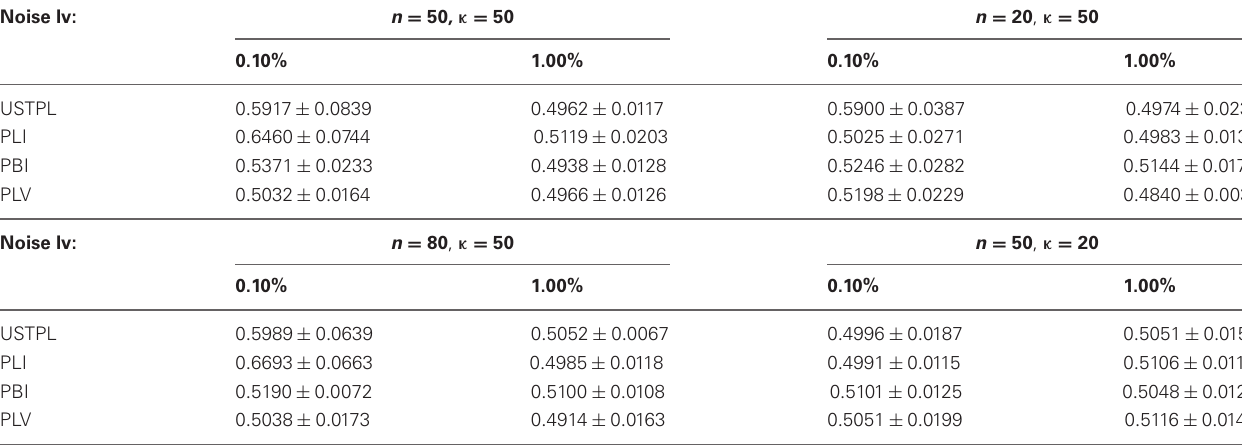
Table 2 | Performance of all three methods for various noise levels, number of trials ( n ), and concentration factors ( κ ). Noise lv: n = 50, κ = 50 n = 20 , κ = 50 0.10% 1.00% 0.10%